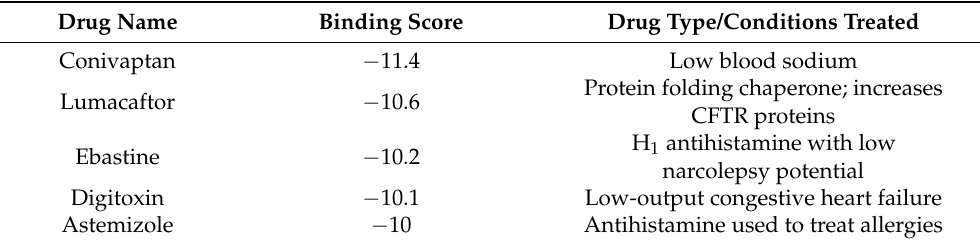
Table 2. Top drug candidates are shown, along with their binding scores and the conditions they were FDA-approved to treat.